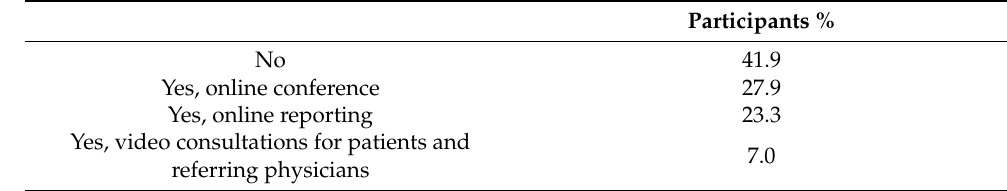
Table 7. Using online tools in radiology department during COVID-19